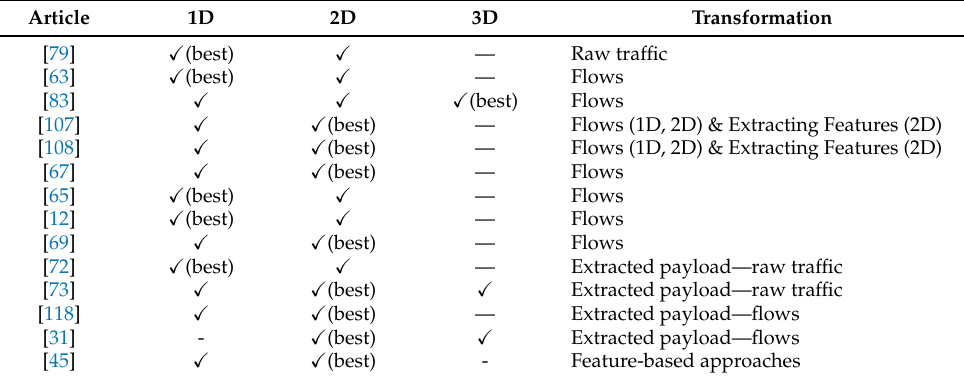
Table 10. The comparison of papers using more than one transformation model for CNN entry